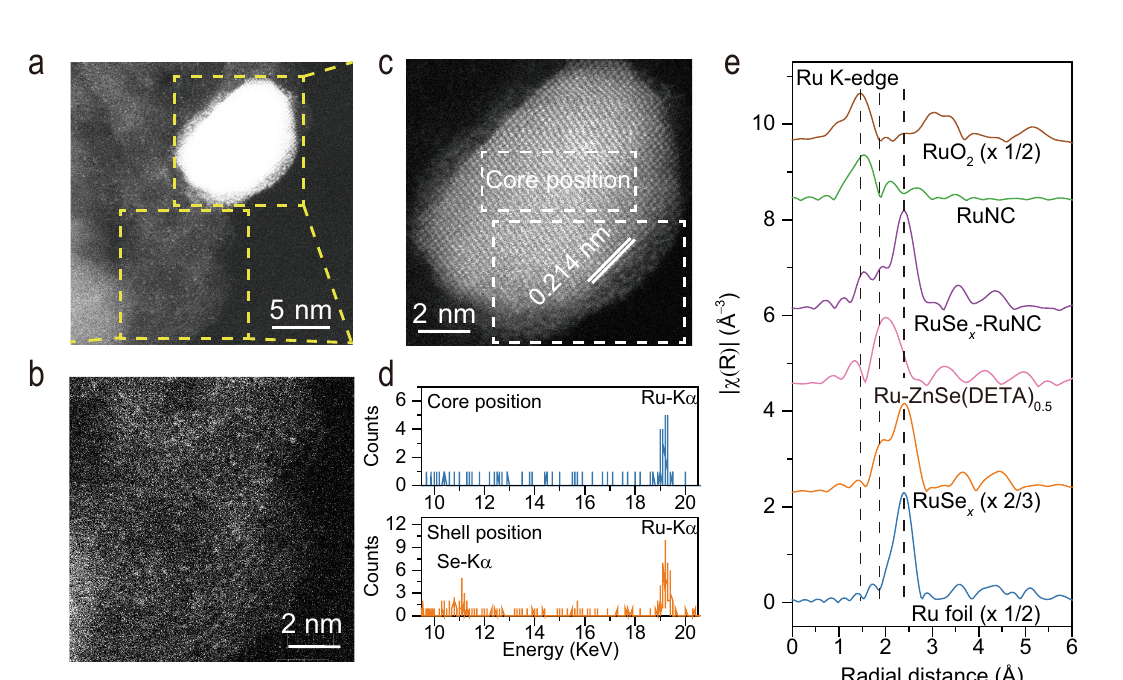
Fig.2|CharacterizationsonthemorphologyandmicrostructureofReSe x – RuNC.a , b SEMimages. c , d TEMimages. e HRTEMimageandcorrespondingFFTpattern. f HAADF-STEM images and element analysis by STEM-EDX.